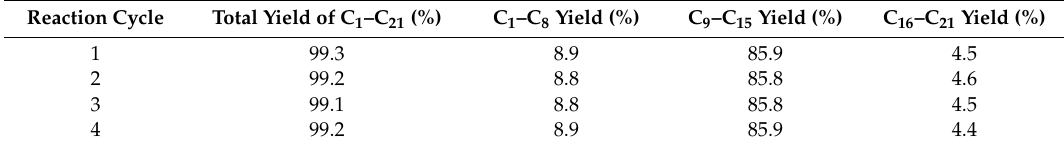
Table 3. Reusability of Pt / Al / MCM-48 in the hydrocracking of polyethylene at 573 K for 4 h 1 . Reaction